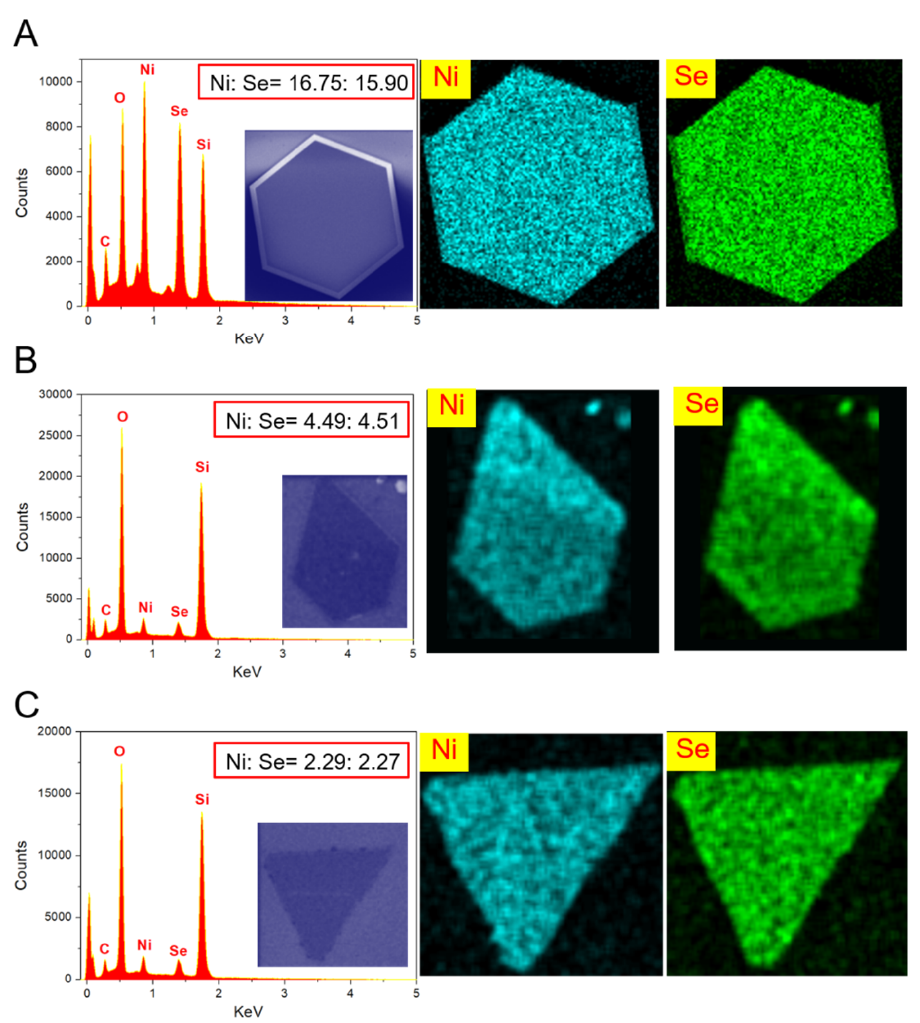
Figure 2. The energy-dispersive X-ray spectroscopy (EDX) characterization and mapping images of as-grown NiSe flakes. ( A ) The EDX curve and corresponding mapping images of hexagon-like NiSe flake. ( B ) The EDX curve and corresponding mapping images of pentagon-like NiSe flake. ( C ) The EDX curve and corresponding mapping images of triangle-like NiSe flake. Insets show the SEM images.